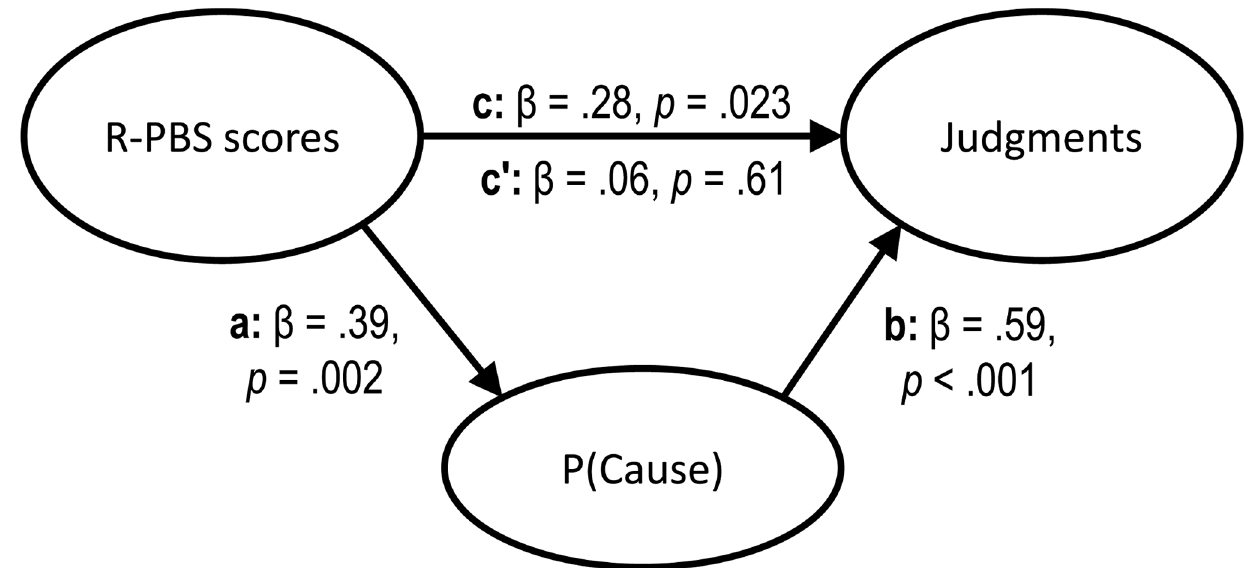
Fig 1. Mediational structure tested in the noncontingent condition. The total effect of the paranormal belief (R-PBS) scores on judgments (depicted as pathway c) was partitioned into one indirect effect via P(Cause) (pathways a and b), and one direct effect (pathway c'), which is the result of discounting the indirect effect. The results of this study suggest that prior paranormal beliefs increased the tendency to develop new causal illusions via the mediation of a biased exposure to cause-present